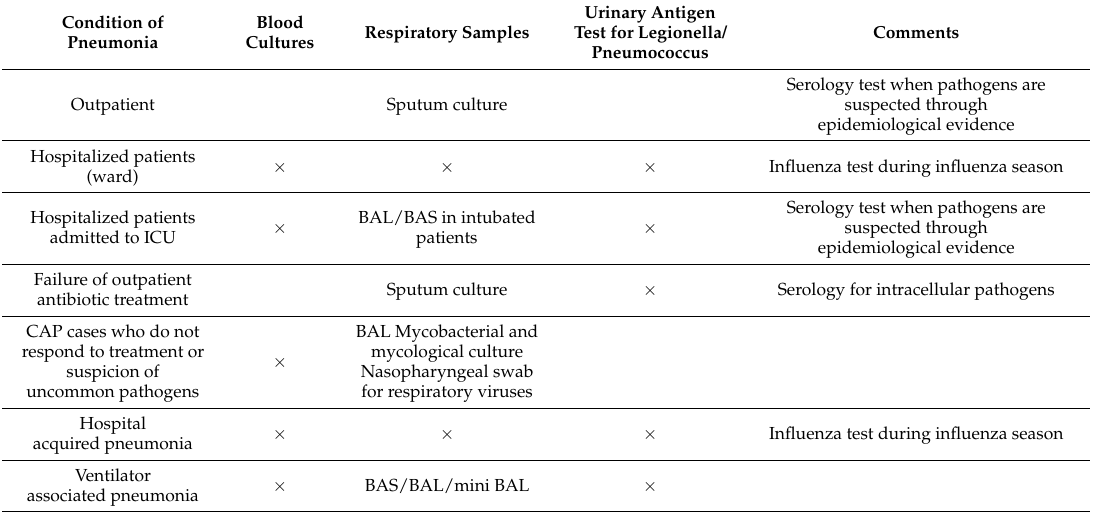
Table 1. Samples and Diagnostic Testing in